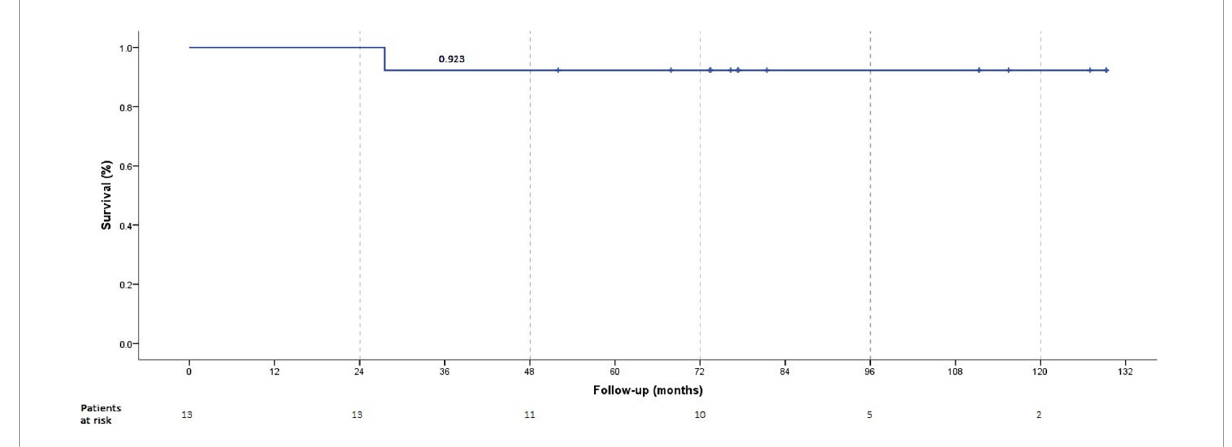
FIGURE1 One to 6 years survival rates.